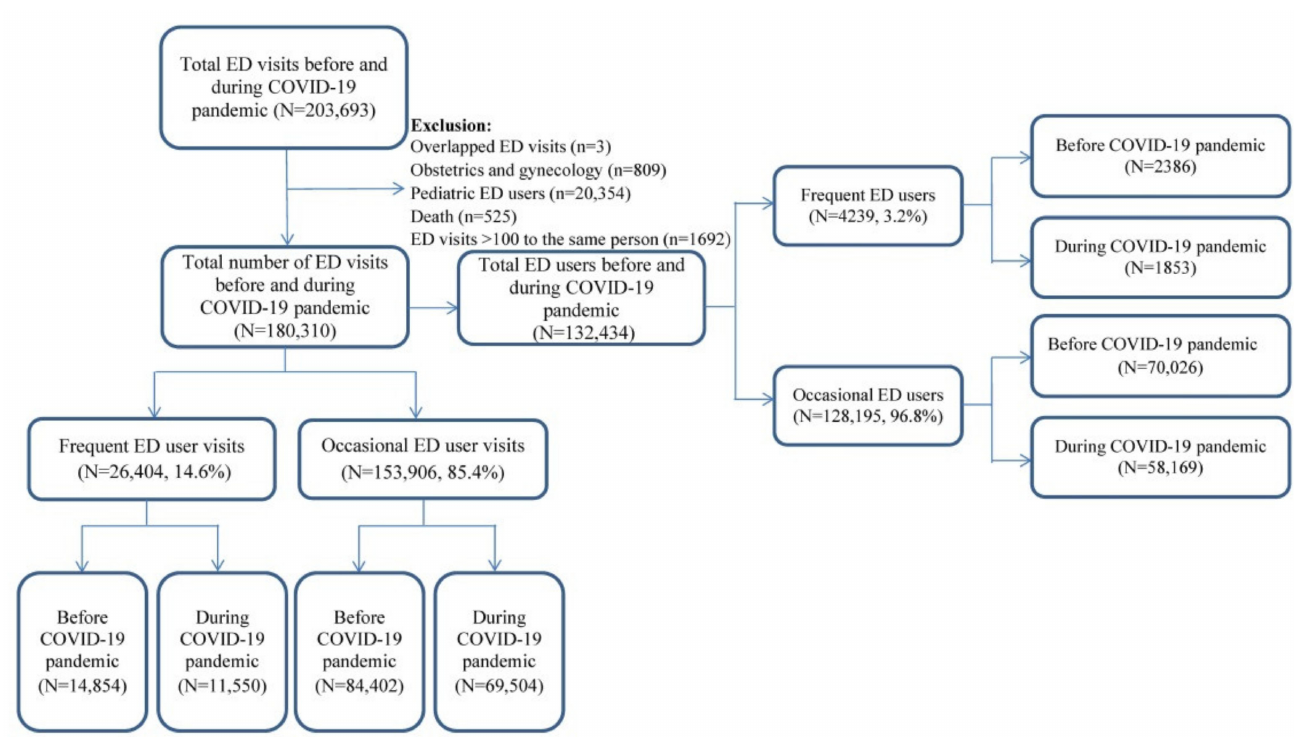
Figure 1. Flow chart of the patient selection